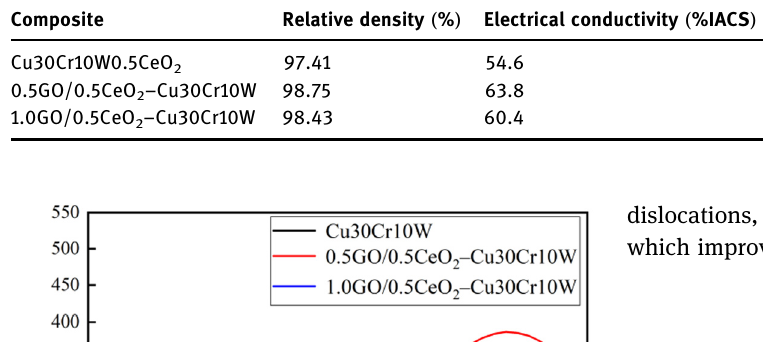
Table 1: Comprehensive properties of composites Composite